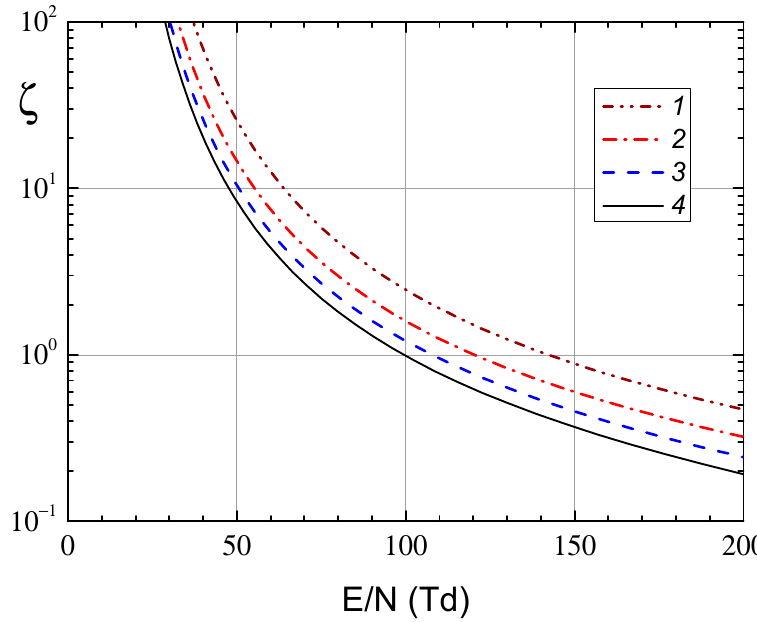
Figure 9. A dependence of parameter ζ on a reduced field E/N in RF discharge with a frequency of 13.56 MHz and inter-electrode distance L = 5 cm at various argon pressures: curve 1—3 Pa, curve 2—4 Pa, curve 3—5 Pa, curve 4—6 Pa.